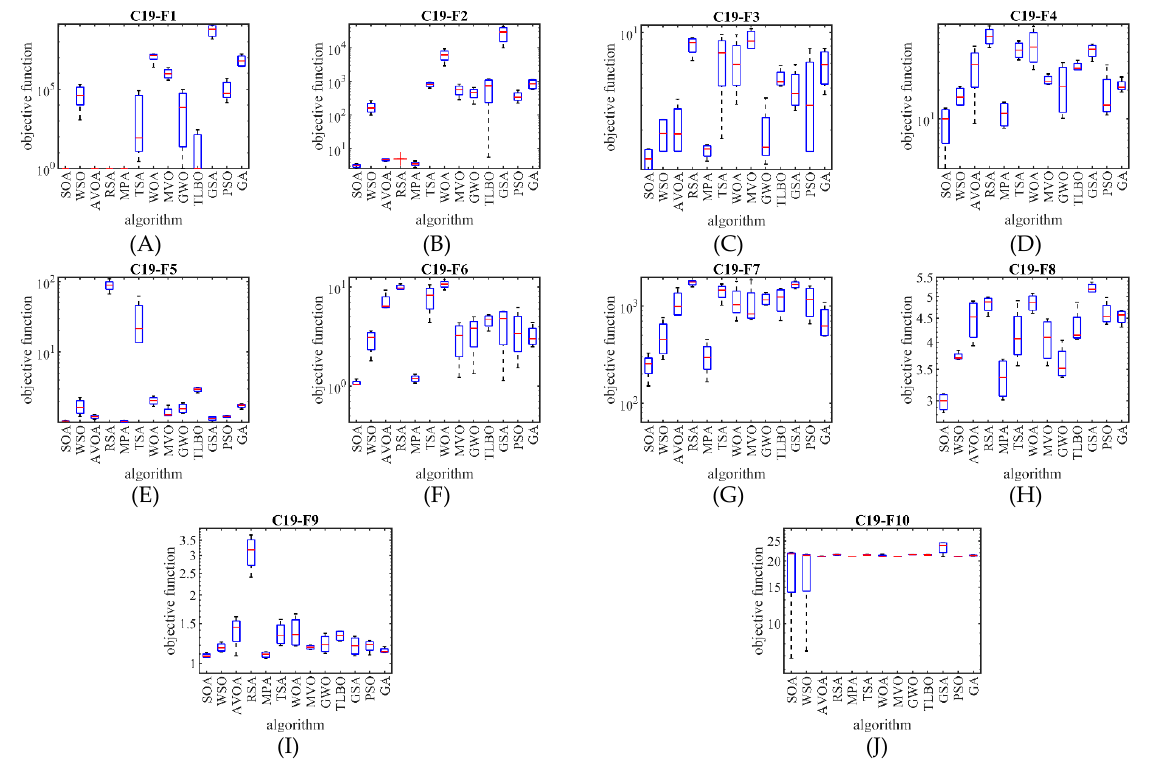
Figure 6. Boxplot diagram of SOA and competitor algorithms performances on the CEC 2019 test suite.